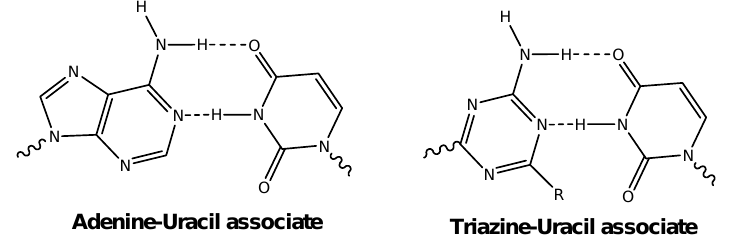
Figure 3. Interaction between nucleic bases (adenine-uracil) and monoaminotriazine derivatives with uracil.